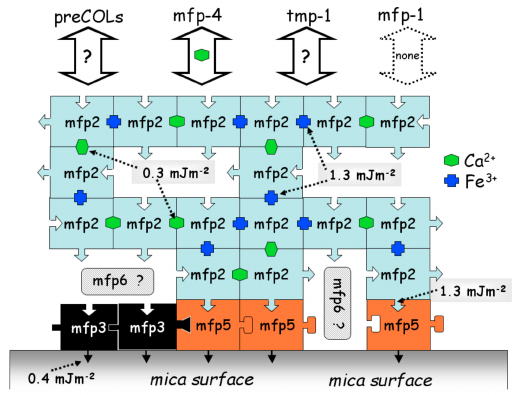
Figure 2. Interactions between metals and proteins in the byssal plaque of Mytilus. Reproduced with permission from Ref. [51], Copyright 2004 Wiley-VCH Verlag GmbH & Co. KGaA.